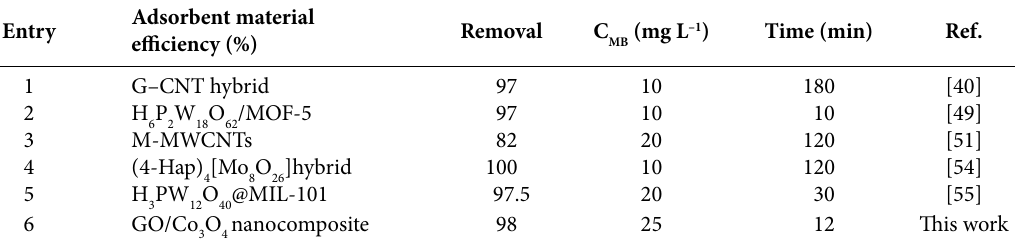
Table 3. The comparative removal efficiency of MB with different adsorbents.